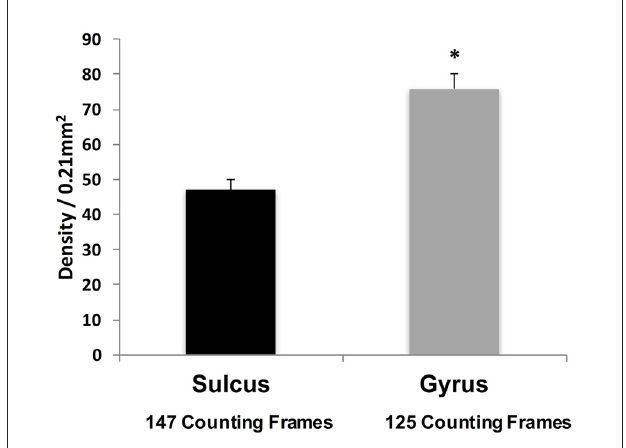
FIGURE 3 | Density of WMNs in sulcal depth and gyral crown in eight monkeys, averaged across all four regions. ∗ p < 0.05, gyrus compared to